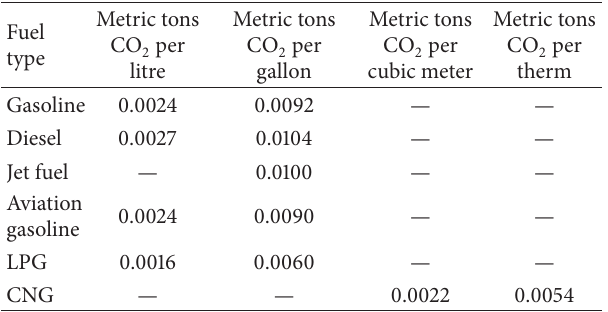
Table 6: CO emission factors for combustion of common fossil 2 fuels [7].